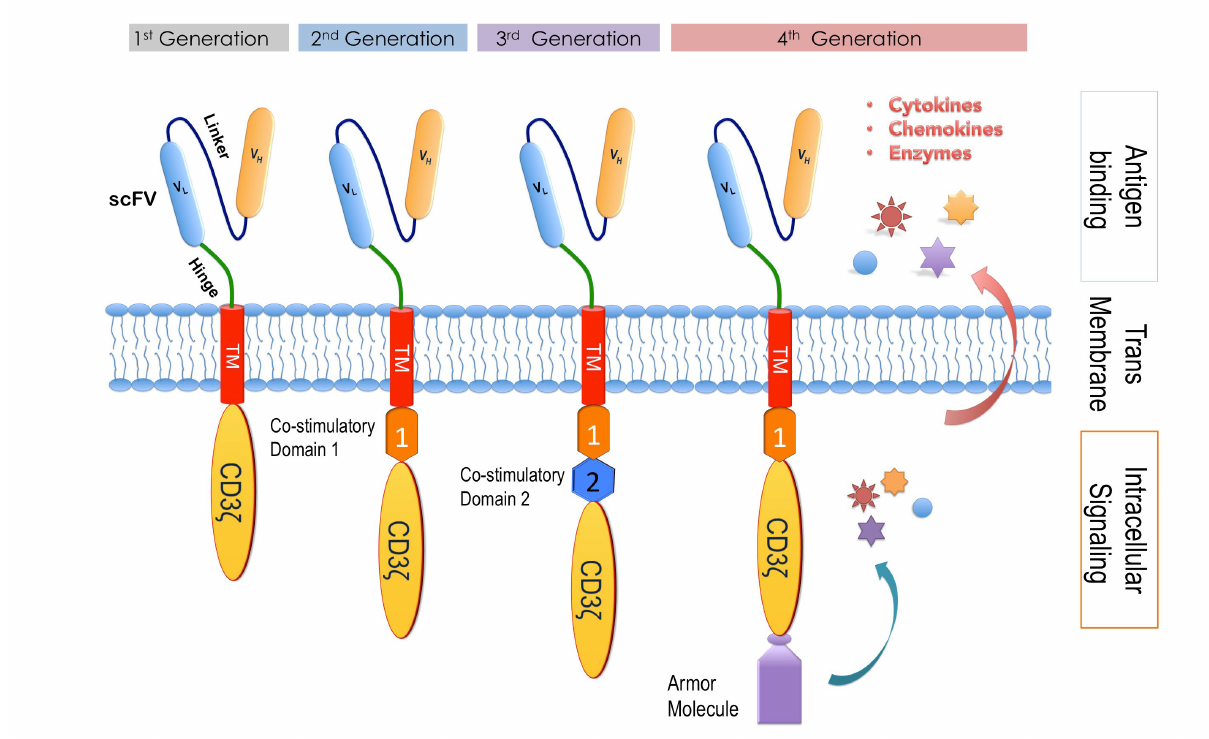
Figure 2. The evolution of CAR. The figure illustrates the different designs of CAR with the addition of various functional